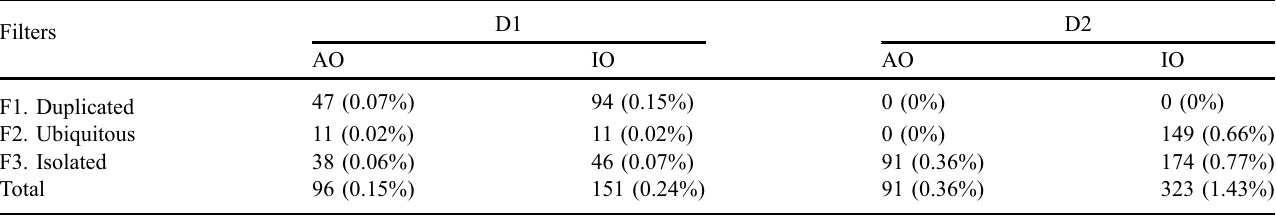
Table 2. Number and percentage (in brackets) of structural errors for the different datasets in the Atlantic Ocean (AO) and the Indian Ocean (IO).